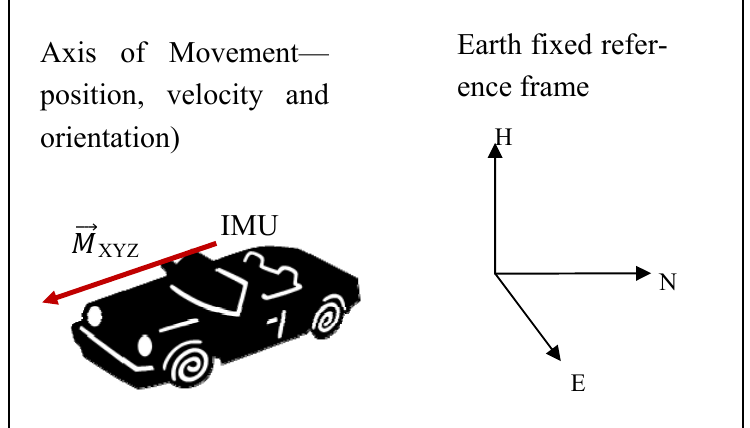
Figure 2. Inertial measuring